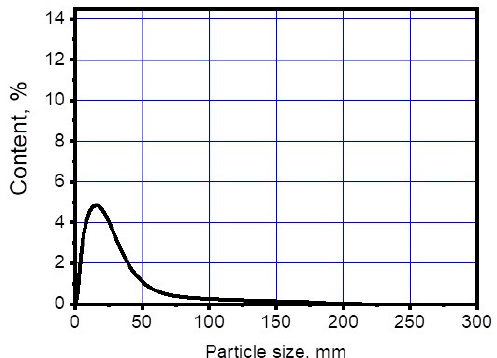
Figure 2. Size distribution of the magnetite particles synthesized ( a ) without a stabilizer; ( b ) using sodium stearate as the stabilizer.